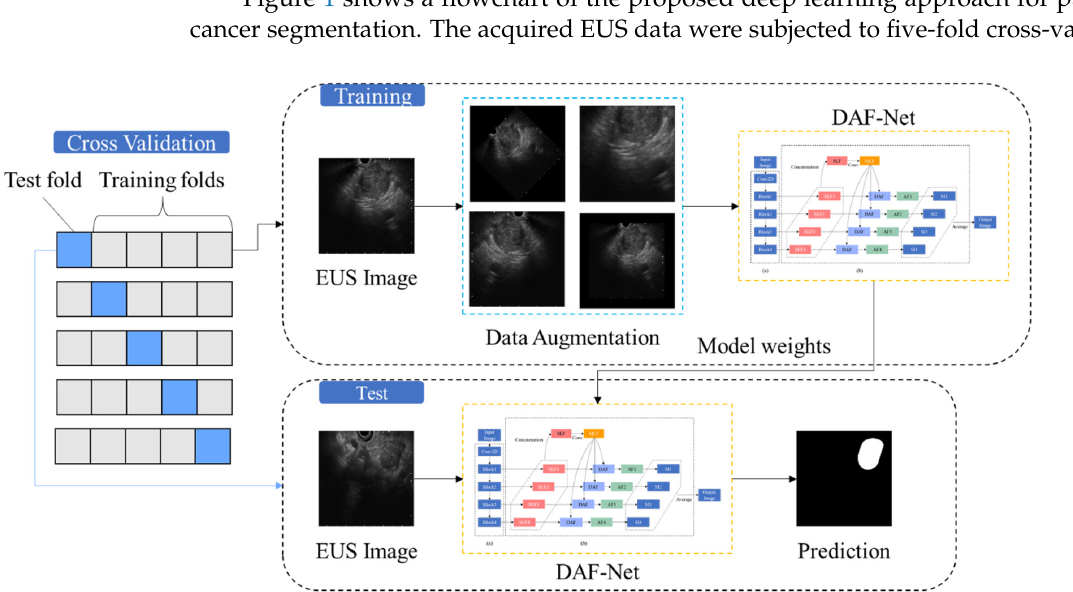
Table 1. Characteristics of the patients and cancer.